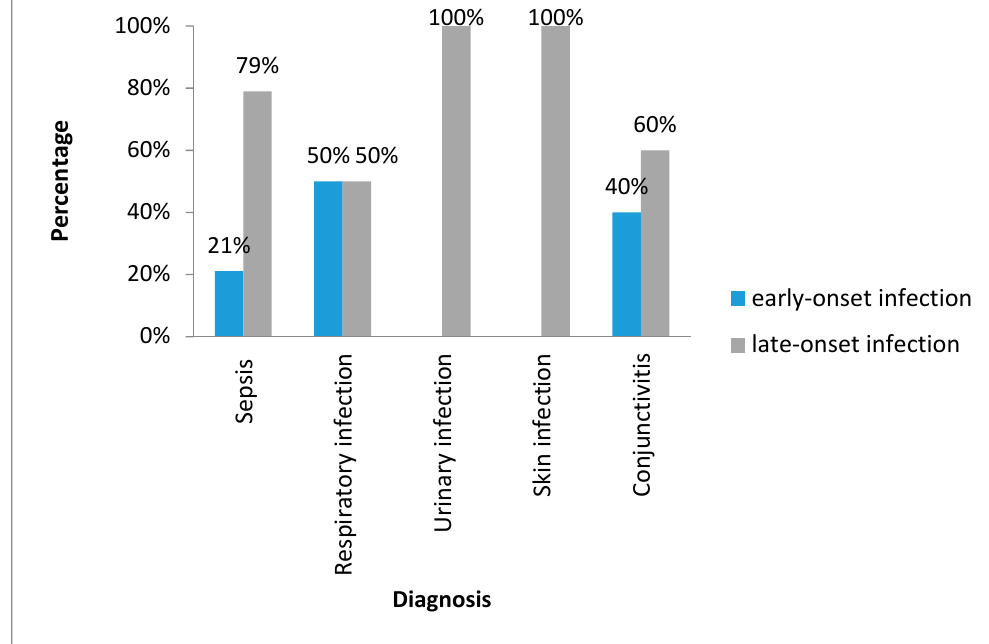
Table 1. Risk factors in neonatal infections with Gram-negative bacilli, Havana, 2017–2018. Risk Factors